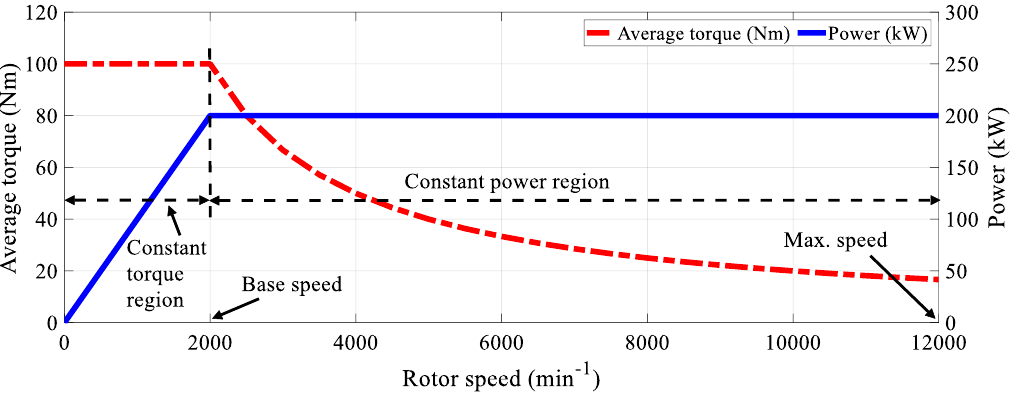
Figure 1. Typical CPSR characteristics curve for EV drivetrains.